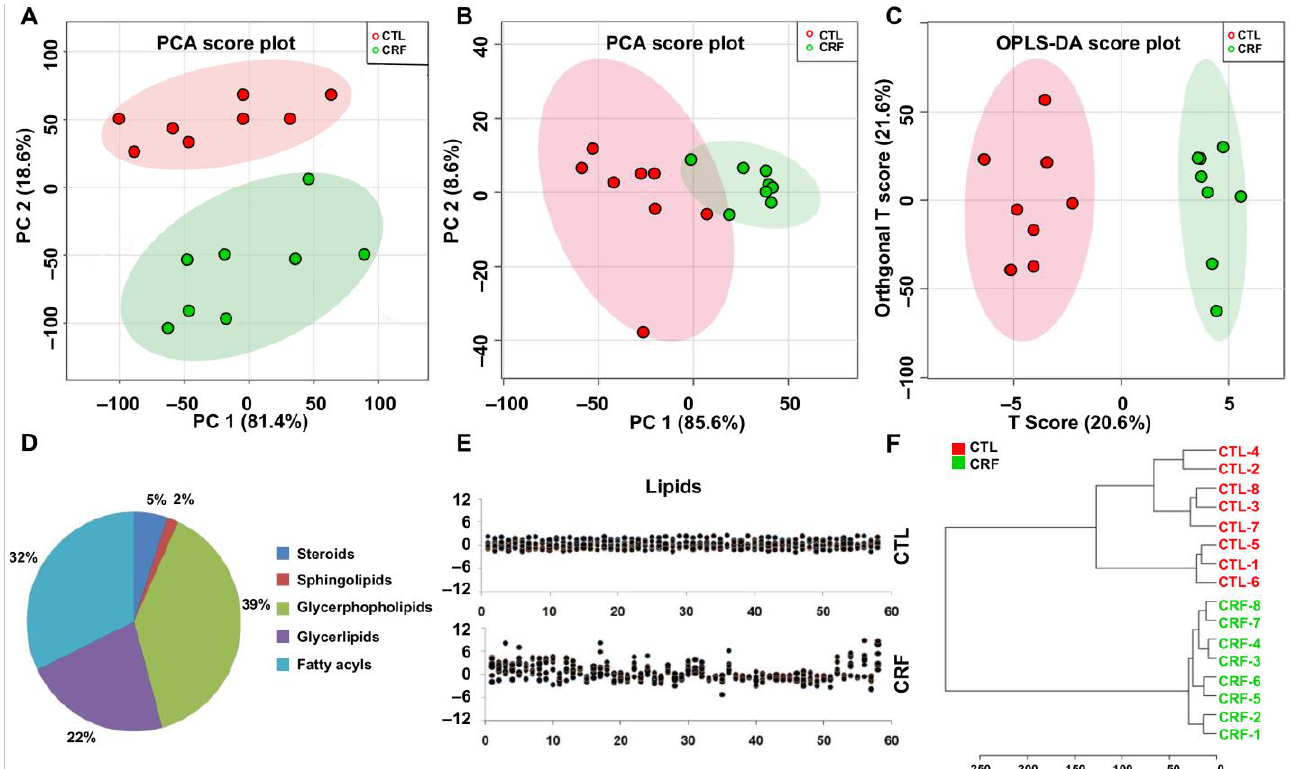
Figure 1. Altered lipid profiles were involved in chronic renal failure (CRF). ( A ) PCA plots with the scores of the first two principal components from CRF and control rats. ( B ) PCA plots with the scores of the first two principal components based on 58 lipid species from CRF and control rats. ( C ) OPLS-DA scores plots of the first two principal components based on 58 lipid species from CRF and control rats. ( D ) Pie chart presents the distribution of different classifications of 58 lipid species in CRF and control rats. ( E ) z-score plot of 58 altered lipid species in control and CRF rats. Each point represents an individual lipid in one sample. Z-score plots for the data are normalized to the mean of control samples. ( F ) Dendrogram of hierarchical clustering analysis based on 58 lipid species from CRF and control rats. Table 1. Identification of significantly differential endogenous lipids in the rat serum.